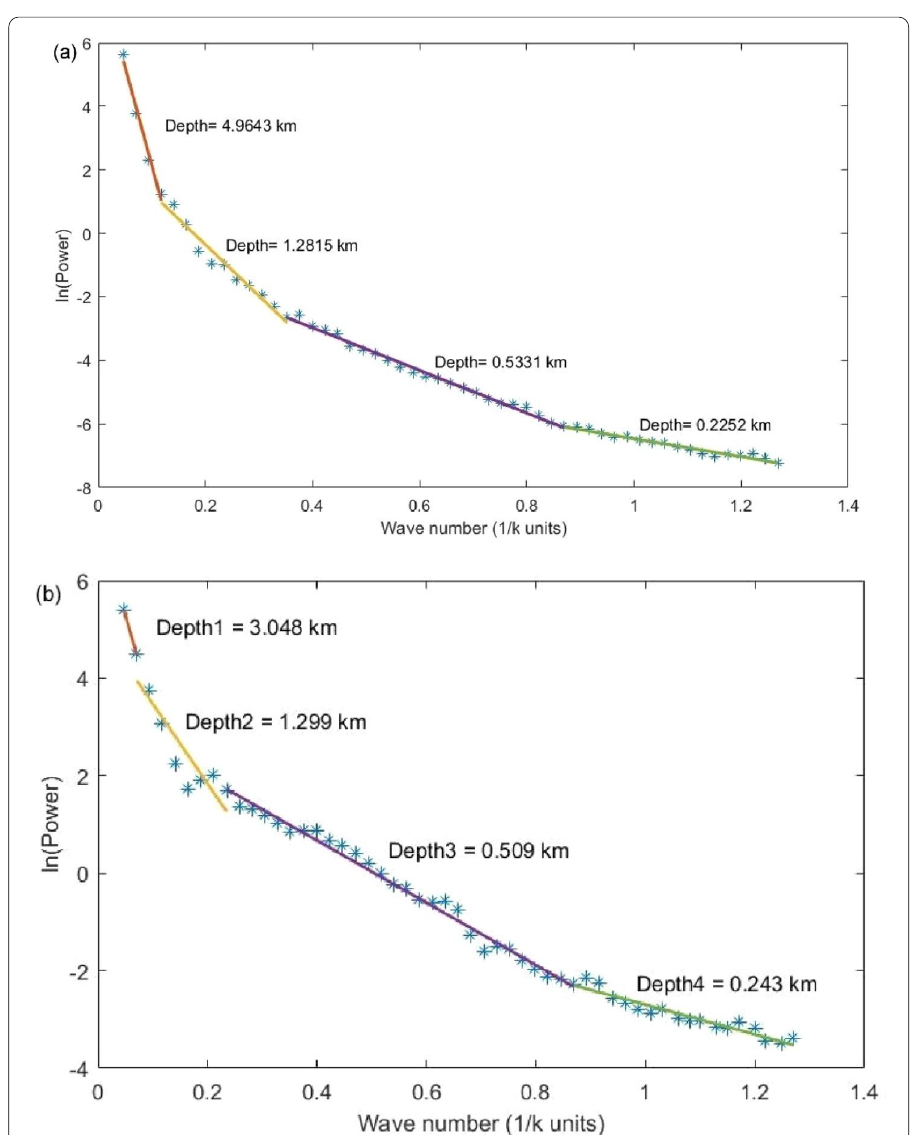
Fig. 6 2D radially averaged power spectrum of a residual Bouguer anomaly data; b RTE total magnetic anomaly